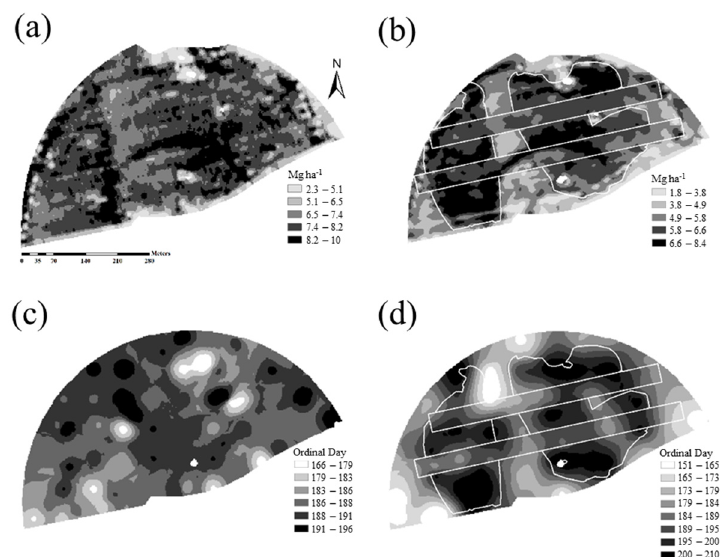
Figure 5. Interpolated maps of yield and the onset of crop water stress ( a ) yield under uniform irrigation ( b ) yield with spatially variable irrigation treatments ( c ) onset of crop water stress under uniform irrigation ( d ) onset of crop water stress under spatially variable